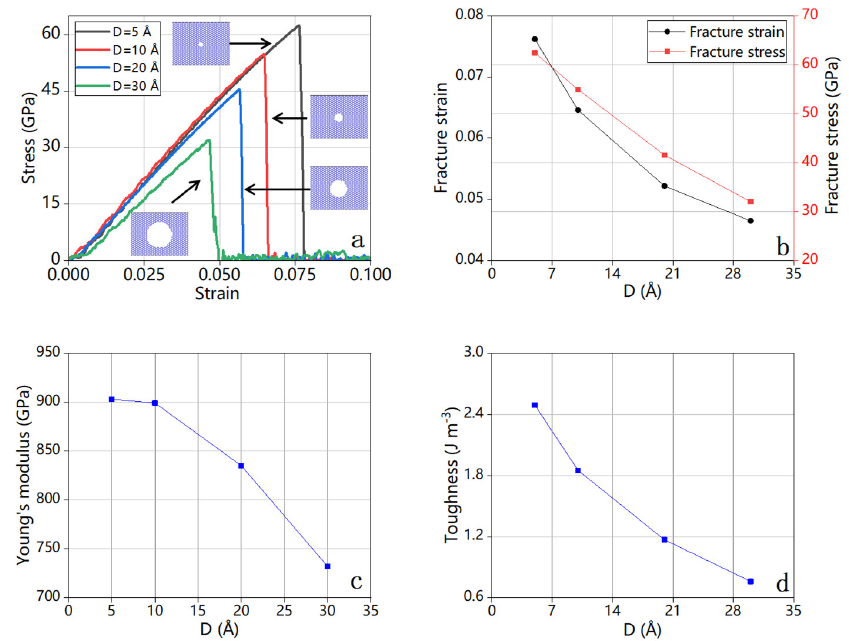
Figure 6. Mechanical properties analysis of bilayer-crack graphene with circular cracks of different diameters D ( a ) Stress–strain relationships ( b ) Fracture strain, ( c ) Fracture stress, ( d ) Young’s modulus. Both Young’s modulus and fracture toughness decayed with the increasing size of the circular